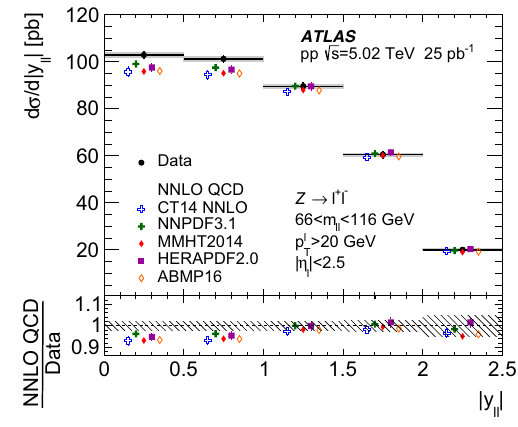
Fig. 12 Differential cross section for Z boson production as a func- tion of absolute lepton-pair rapidity compared with theoretical predic- tions. Statistical and systematic errors are shown as corresponding bars and shaded bands on the data points. The luminosity uncertainty is not included. Only the dominant uncertainty (PDF) is displayed for the the- ory. The lower panel shows the ratio of predictions to the measured differential cross section in each bin, and the shaded band shows the sum in quadrature of statistical and systematic uncertainties of the data